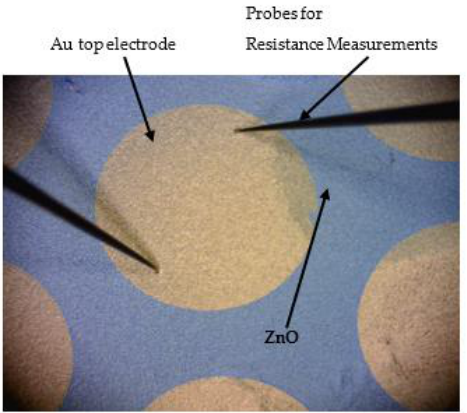
Figure 3. Gold power collection electrodes resistance was measured during stretching using a probe station.